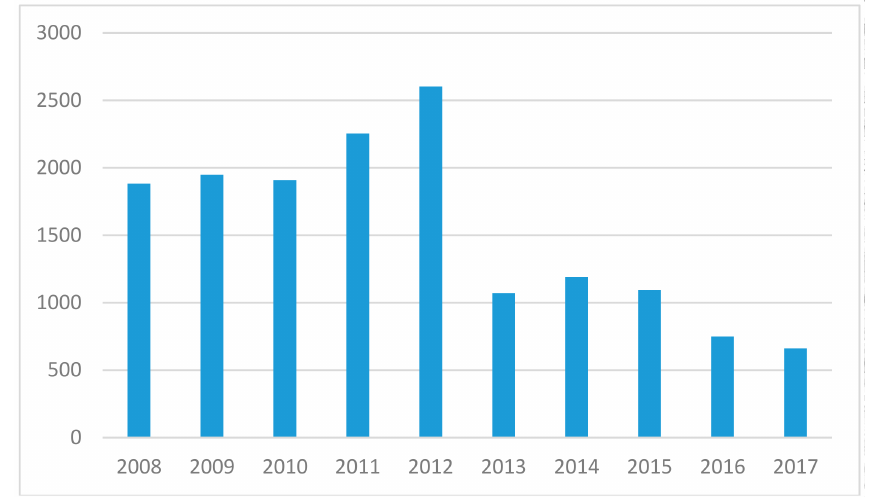
Figure 1. Number of applications sent to Swedish AECs from 2008 to 2017, showing a marked decline from 2013 when application costs